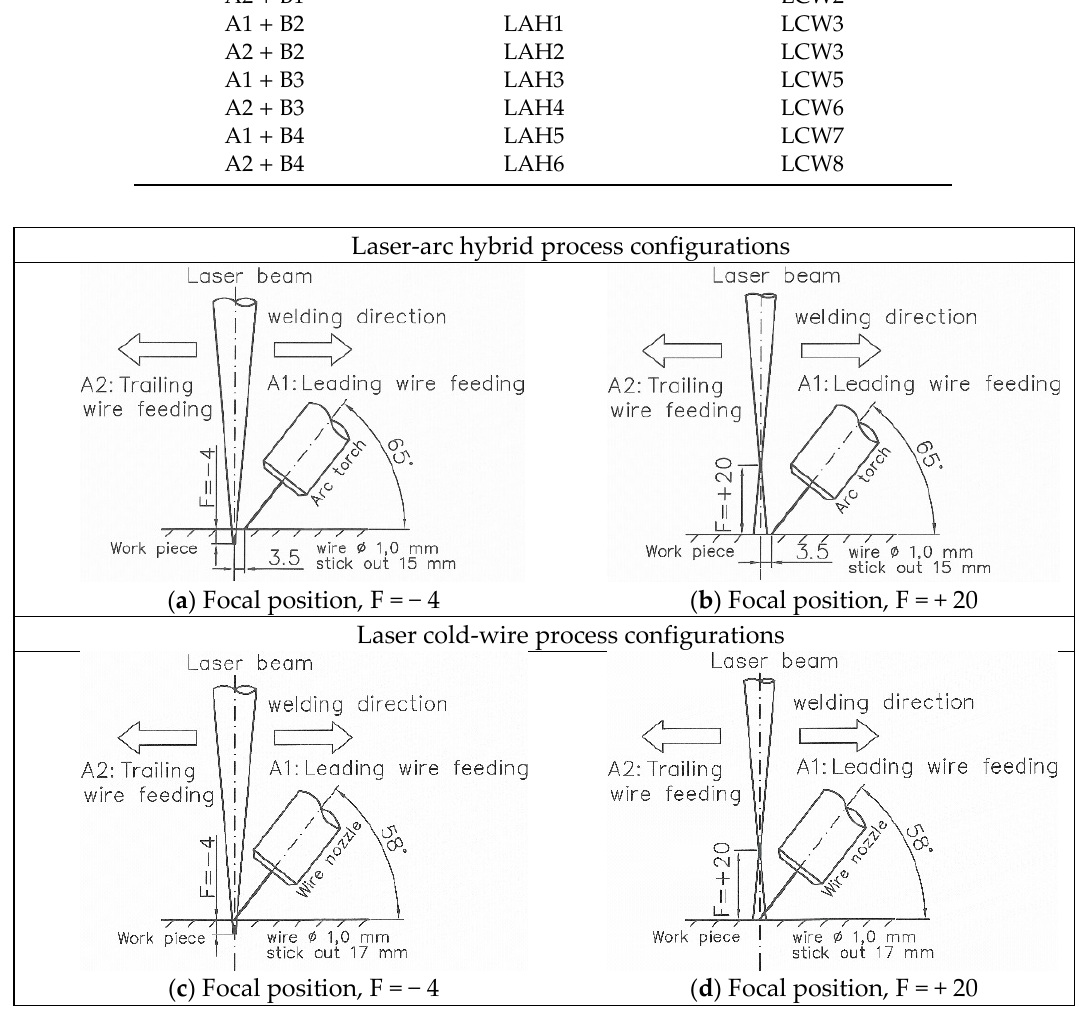
Figure 3. Set-up of laser beam and filler wire feeding arrangements used in laser-arc hybrid welding (upper row; a – b ) and laser cold-wire welding (lower row; c – d ). A1 = leading wire feeding. A2 = trailing wire feeding.